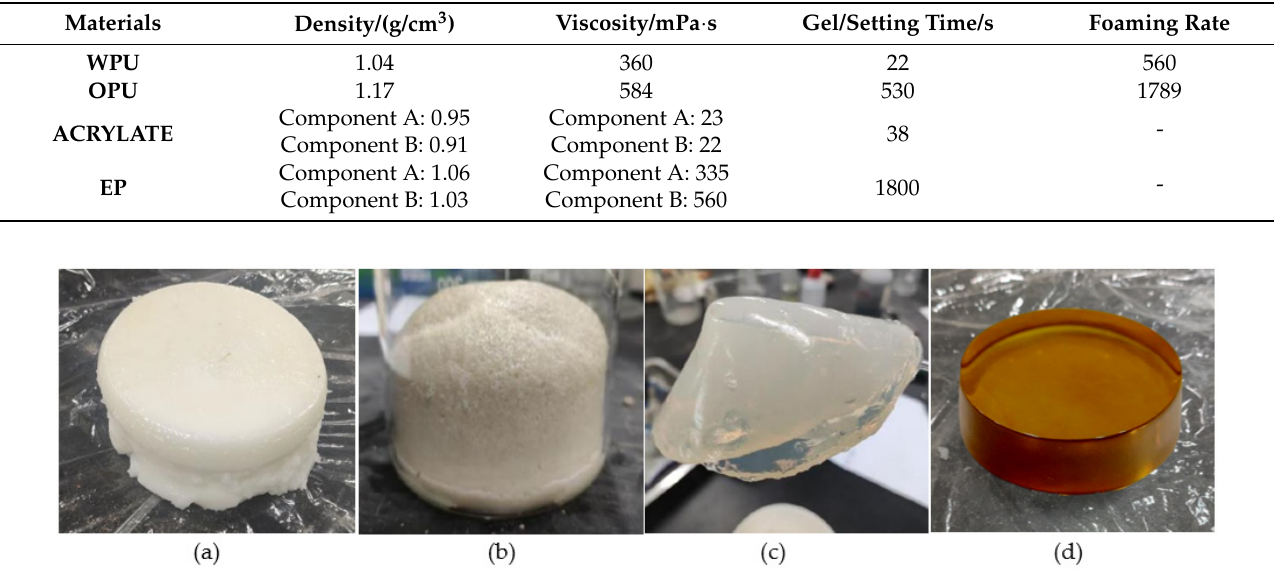
Figure 3. Polymer slurry gel or solidification state: ( a ) WPU; ( b ) OPU; ( c ) acrylate; ( d ) EP.